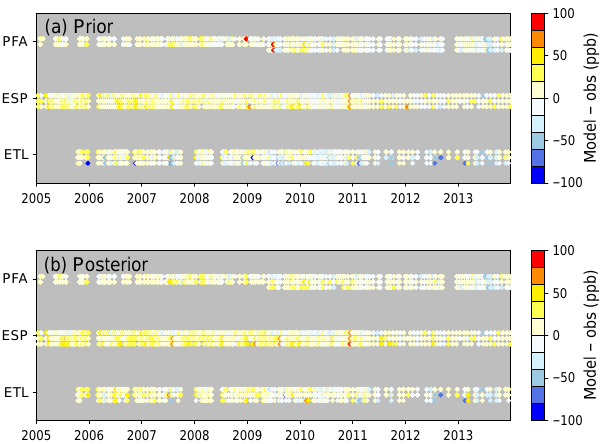
Figure 7. Comparison of simulated concentrations from scenario S1 with independent observations from NOAA aircraft campaigns at Poker Flats (PFA), Estevan Point (ESP), and East Trout Lake (ETL) in Canada. The three rows of dots from top to bottom are the comparison for the mean of data between 4 and 10km, 1 and 4km, and 0 and 1km. Prior concentrations (a) and posterior concentra- tions (b) .